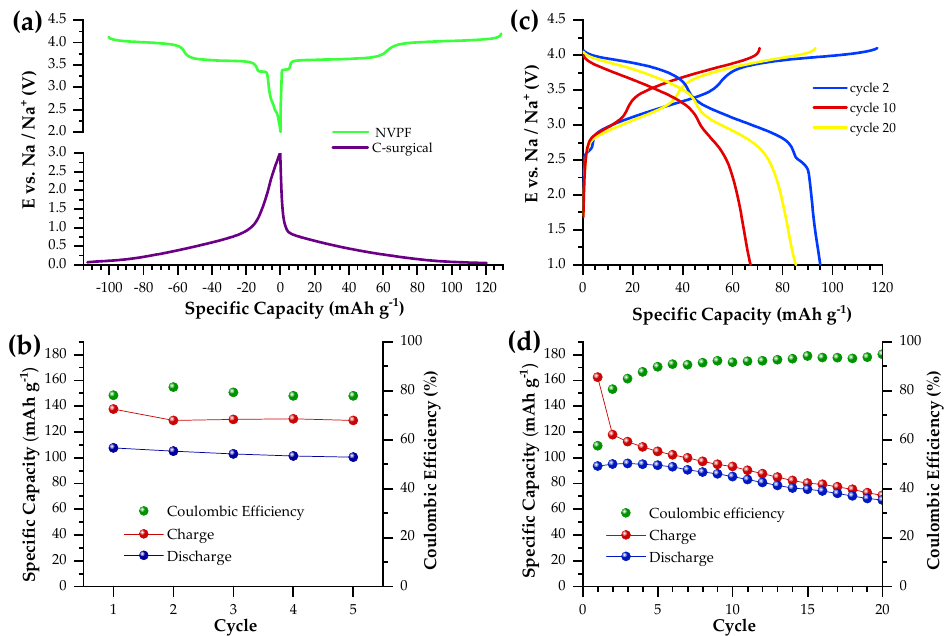
Figure 8. ( a ) Voltage (E) vs. specific capacity profiles at 0.1 mA/cm 2 for C-surgical anode and for NVPF cathode, both with 1 M NaClO 4 in PC as electrolyte vs. Na + /Na. ( b ) Galvanostatic cycling behavior of NVPF at 0.1 mA/cm 2 vs. Na upon 5 cycles. ( c ) Voltage vs. specific capacity profiles at 0.1 mA/cm 2 for the full NVPF/(1 M) NaClO 4 in PC/C-surgical cell at selected cycles in the 1–4.1 V potential range vs. Na. ( d ) Specific capacity and coulombic efficiency of the full cell as a function of cycles upon prolonged cycling at 0.1 mA/cm 2 (C/5).